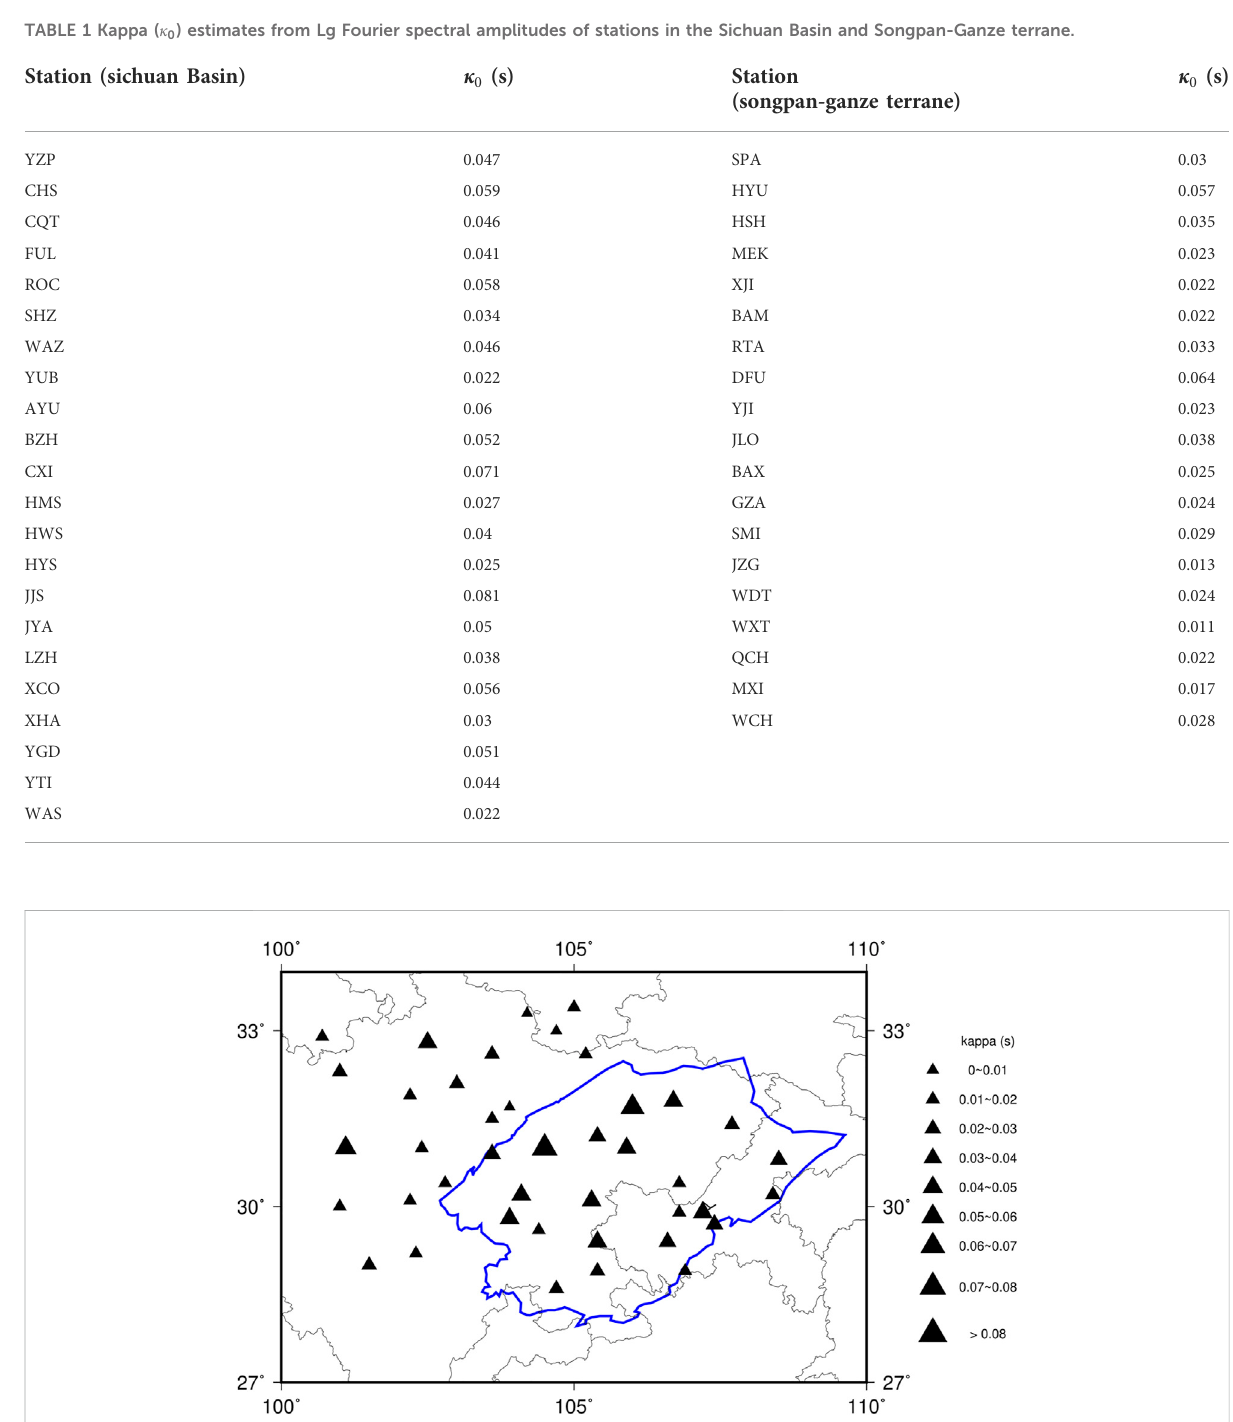
FIGURE 6 κ 0 of stations intheSichuan Basin and Songpan-Ganze terrane plottedatthegeographical locationsof thecorresponding stations. Sizesof the triangles are scaled to the values of κ 0 in seconds. The margin of the Sichuan Basin is shown by the thick